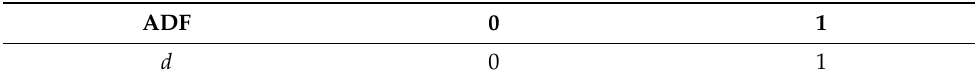
Figure 4. Results of ARIMA model. Table 2. Results of